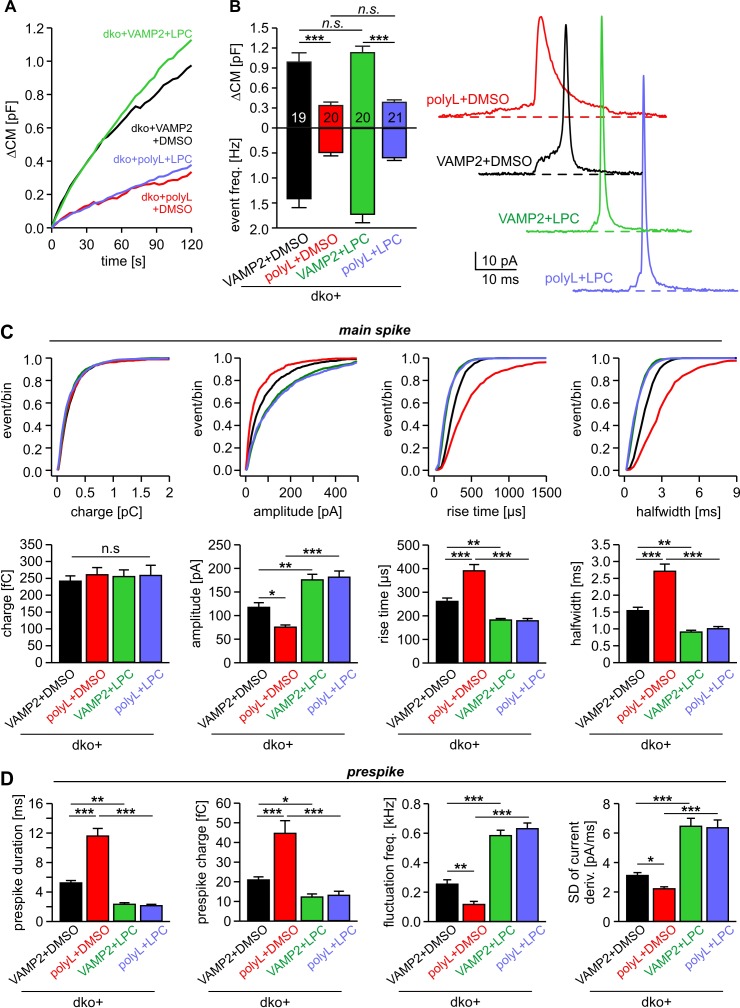
Extracellular LPC overrides the different fusion pore kinetics of VAMP2 and its TMD mutant.(A) Mean capacitance changes in response to stimulus for the indicated groups. (B) Total ∆CM (top) and amperometric event frequency (bottom) show that VAMP2polyL reduces exocytosis, which is unaffected by extracellular LPC application. Data are averaged from the indicated number of cells. Exemplary amperometric events with similar charge but altered release kinetic profile for the indicated group (right panel). (C, D) Cumulative frequency distributions and cell-weighted averages for the indicated parameters of the spike (C) and prespike phase (D) of single fusion events. The VAMP2polyL mutant slows the overall spike and prespike kinetics. Extracellular LPC strongly accelerates the cargo discharge kinetics in VAMP2 and VAMP2polyL expressing cells and overrides the differences in fusion pore expansion between wt and mutant protein. Note that the similar 50–90% spike rise time of wt and VAMP2polyL is not due to signal filtering (2 kHz), which allows for minimum rise times of about 83 µs. Values are given as mean of median determined from the indicated parameter’s frequency distribution for each cell. Data were collected from cells/events measured for dko+VAMP2 (19/1315), dko+VAMP2polyL (20/705), dko+VAMP2+LPC (20/1698) and dko+VAMP2polyL+LPC (21/882). Only cells with >20 events were considered. Data are represented as mean ± SEM. *p<0.05, **p<0.01, ***p<0.001, one-way analysis of variance followed by Tukey-Kramer post test.